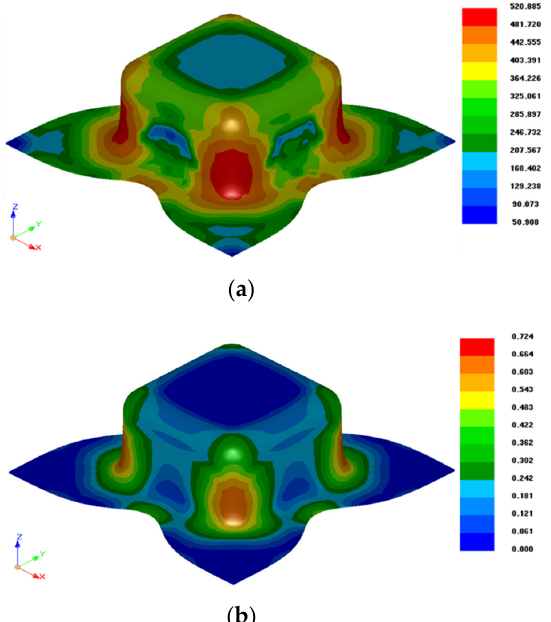
Figure 8. Distributions of ( a ) equivalent stress (unit in MPa) and ( b ) equivalent strain obtained by simulation.